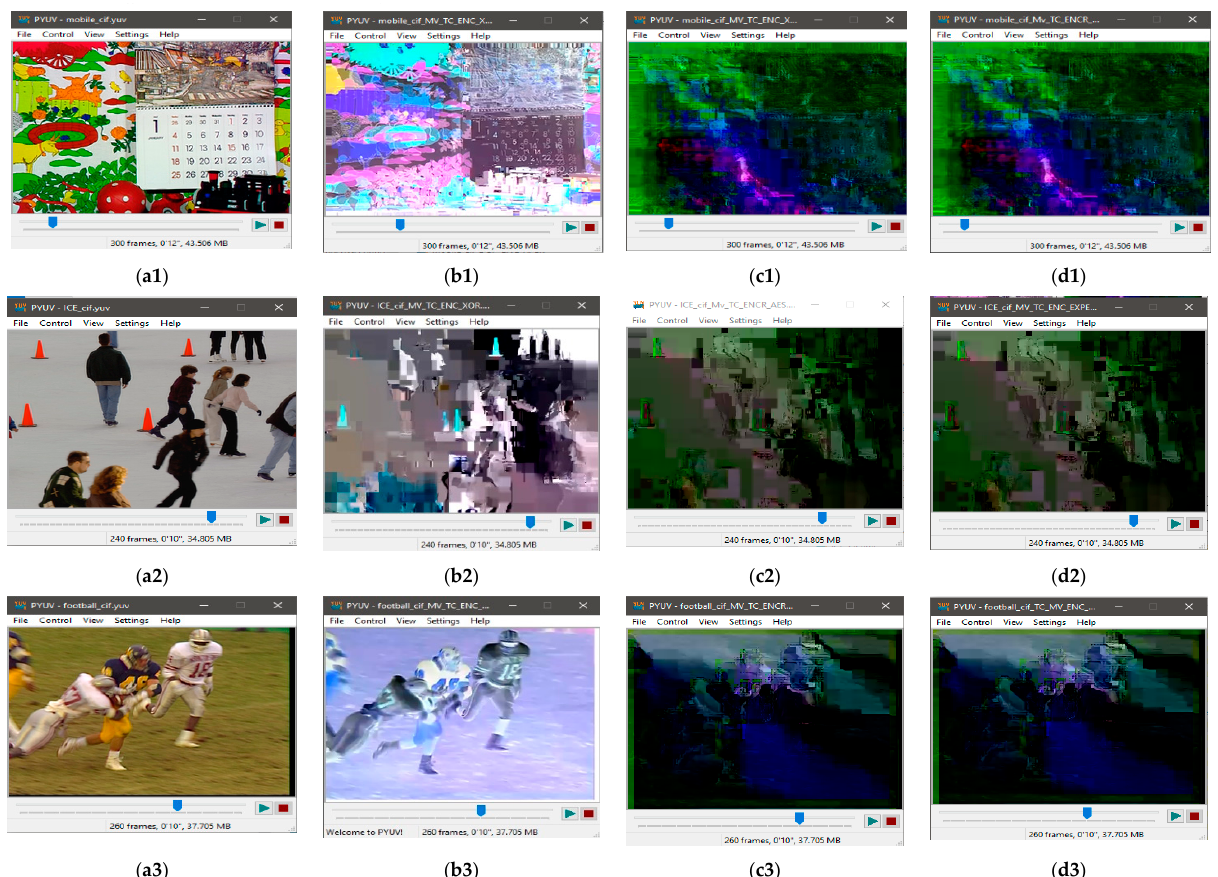
Figure 9. Comparative visual effects of selective encryption (on I, P and B frames) on combined motion + texture syntax elements with XOR, advanced encryption standard (AES)-cipher feedback (CFB) and EXPer on test videos at QP = 36 encoded with CABAC. ( a1 ) Original raw mobile video; ( b1 ) encryption with XOR; ( c1 ) encryption with AES-CFB; ( d1 ) encryption with EXPer; ( a2 ) original raw ICE video; ( b2 ) encryption with XOR; ( c2 ) encryption with AES-CFB; ( d2 ) encryption with EXPer; ( a3 ) original raw football video; ( b3 ) encryption with XOR; ( c3 ) encryption with AES-CFB; ( d3 ) encryption with